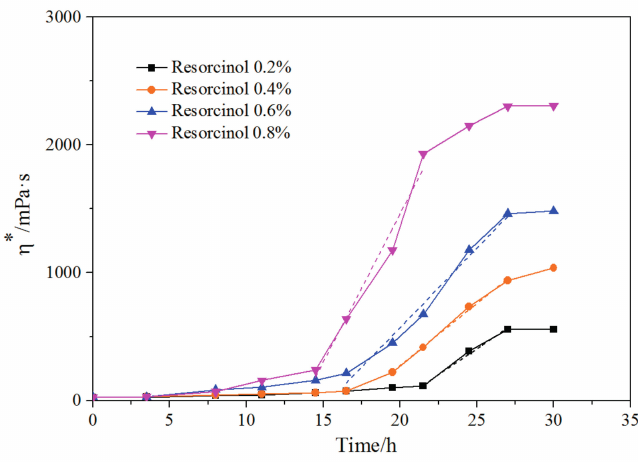
Figure 7. Effect of resorcinol concentration on crosslinking reaction process of the polymer gel.